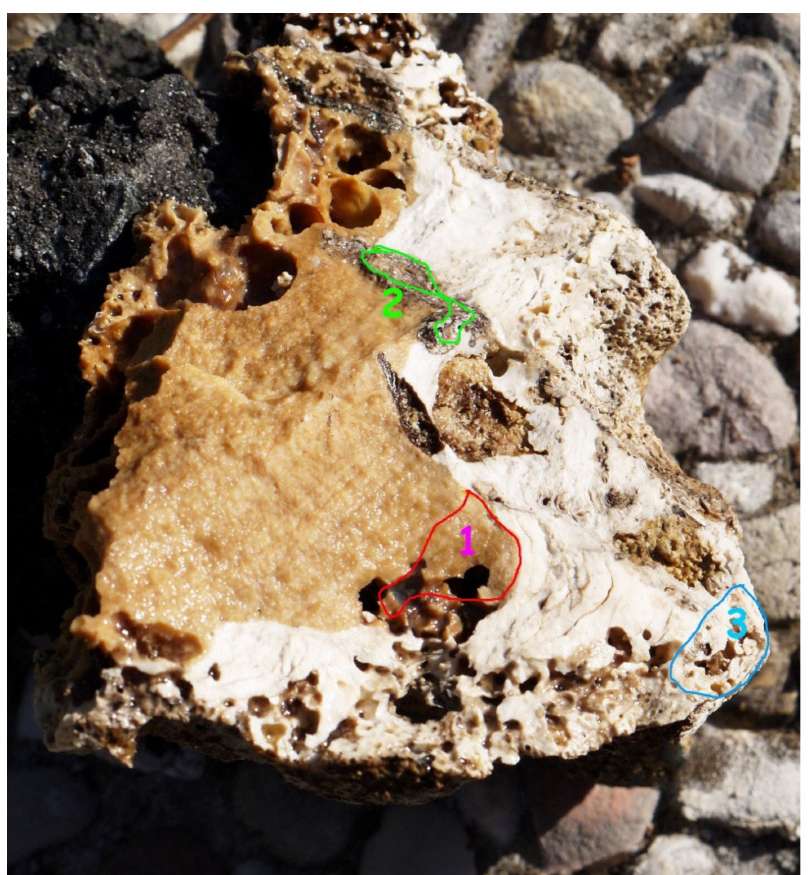
Figure 6. Section of the stalactite sampled at Favignana Island: (1) Continental portion sedimented during MIS 2 (Table 2); (2) the area highlighted in green contains a narrow (3–4 mm) band of